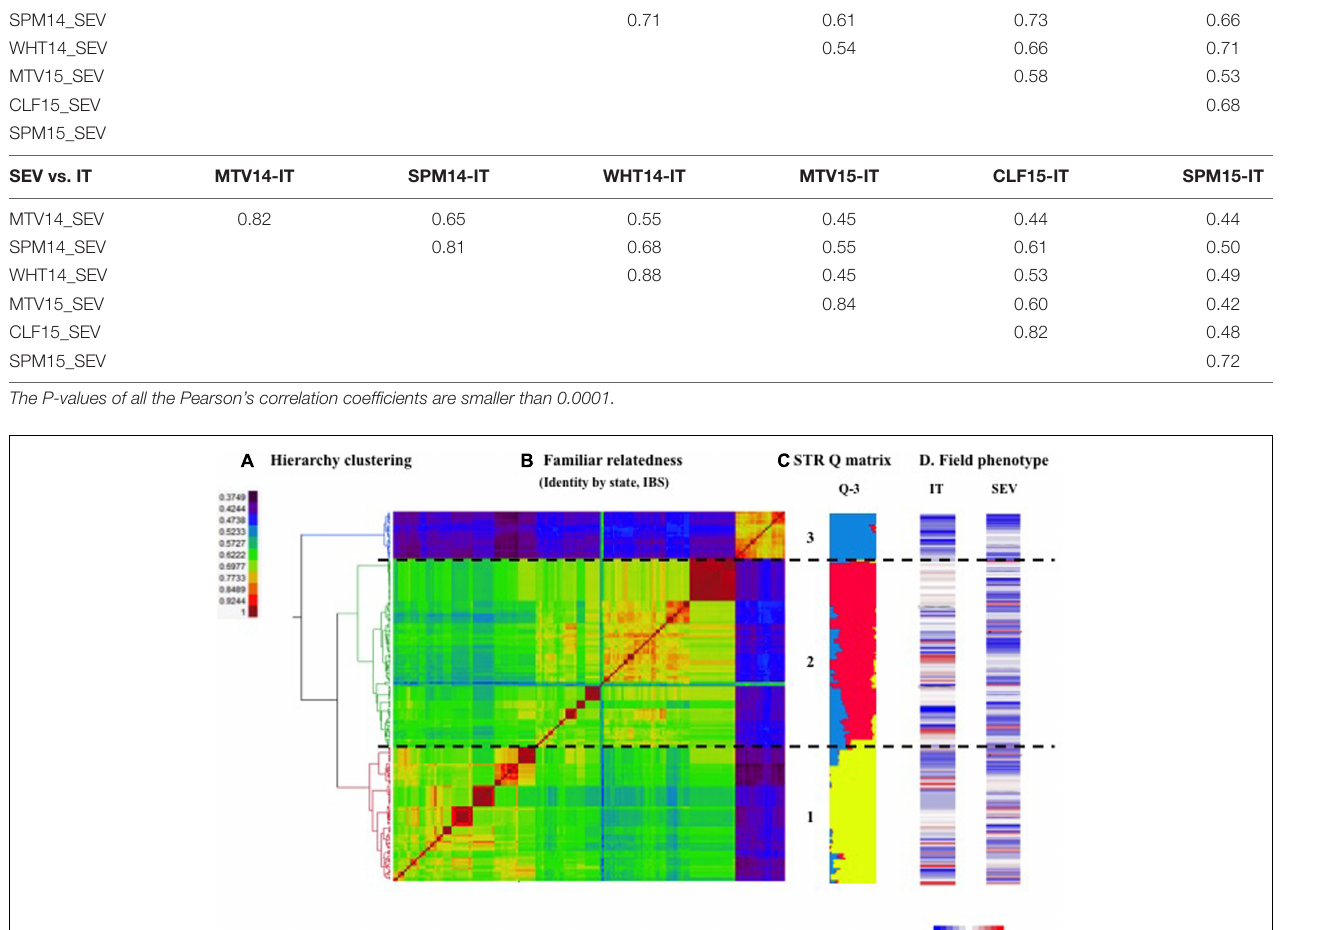
genome, 54% of the pair-wise LD comparisons were significant at P < 0.01, with the mean r 2 of 0.116. A genome had 56% significant marker pairs and an average r 2 of 0.122, and